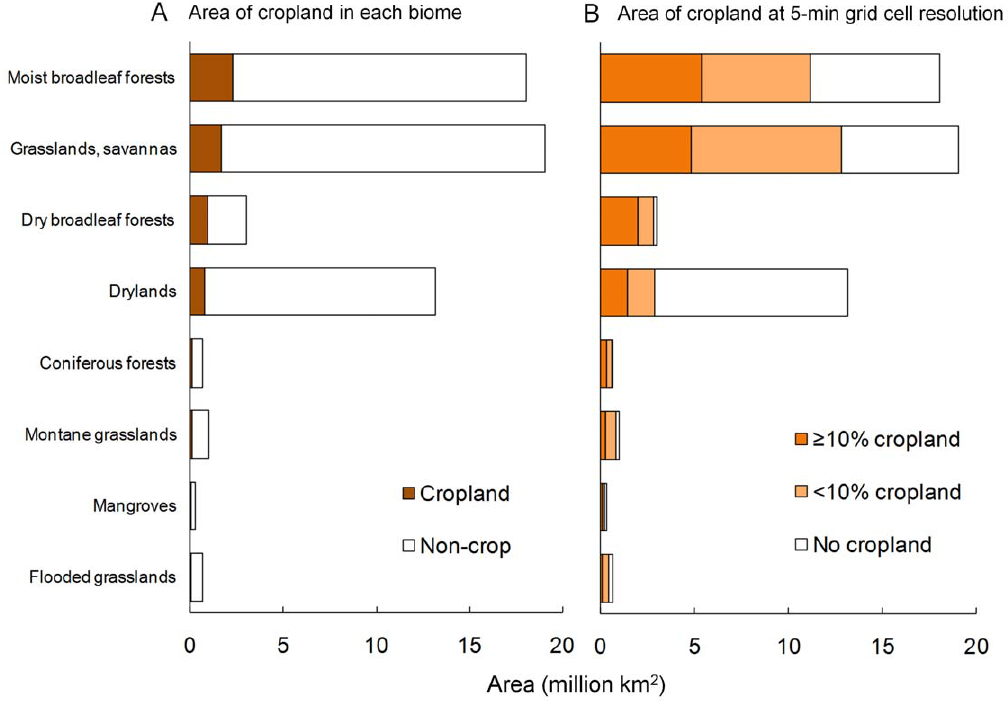
Figure 2. Total area of cropland in biomes within tropical countries. Shaded portions of bars show (A) total area of cropland in each biome, and (B) proportion of 5-min grid cells with , 10% or $ 10% cropland cover, assessed from cropland map of [5]. Lakes, rock and ice, tundra, temperate and mediterranean biomes are excluded.